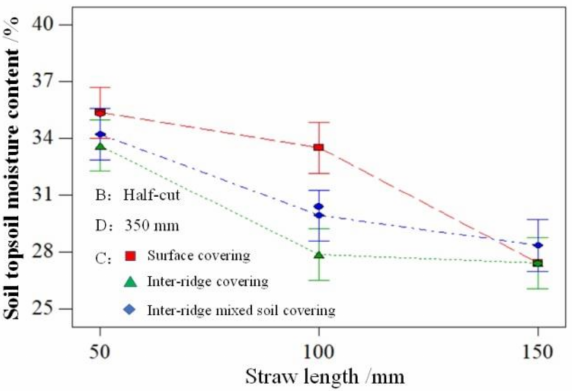
Figure 4. Effect of interaction between straw length and mulching form on soil topsoil moisture